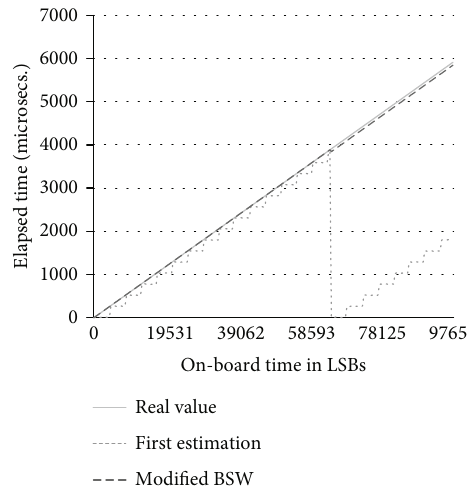
Figure 3: Estimated elapsed time in microseconds as a function of OBT LSBs. Real value compared to BSW calculations before and after modi fi